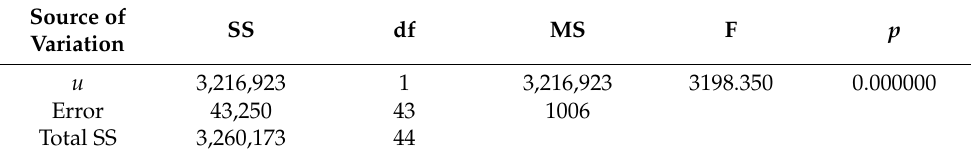
Figure 22. Pareto plots of the standardized effects of empirical full model Young’s modulus E ; the vertical line in the plot corresponds to the arbitrarily chosen level of significance ( p = 0.05).